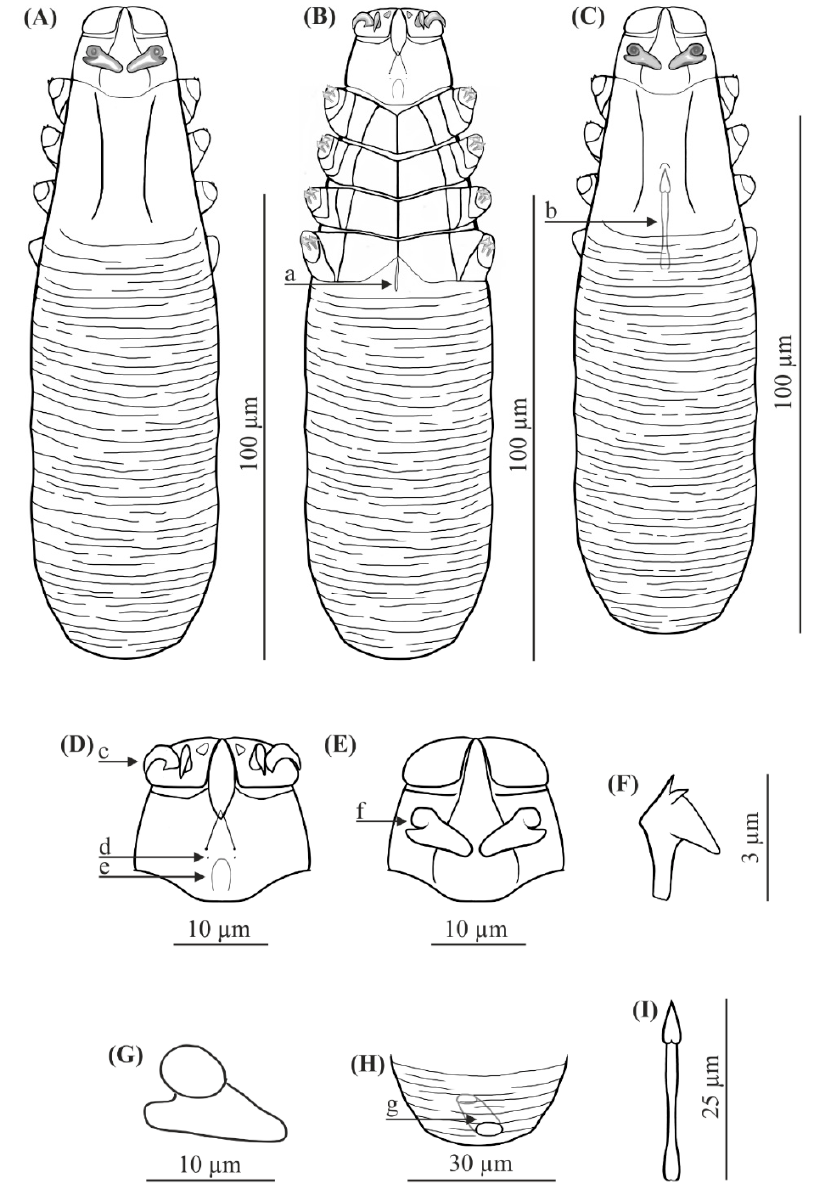
Figure 3. Demodex talpae : female, dorsal view ( A ), female, ventral view ( B ), male, dorsal view ( C ), gnathosoma, female, ventral view ( D ), gnathosoma, female, dorsal view ( E ), claw on the leg ( F ), supracoxal spine ( G ), opisthosomal organ, female ( H ), aedeagus ( I ); a: vulva, b: aedeagus, c: spines on palps, d: subgnathosomal seta (seta n ), e: pharyngeal bulb, f: supracoxal spine (seta elc.p ), g: opisthosomal organ.